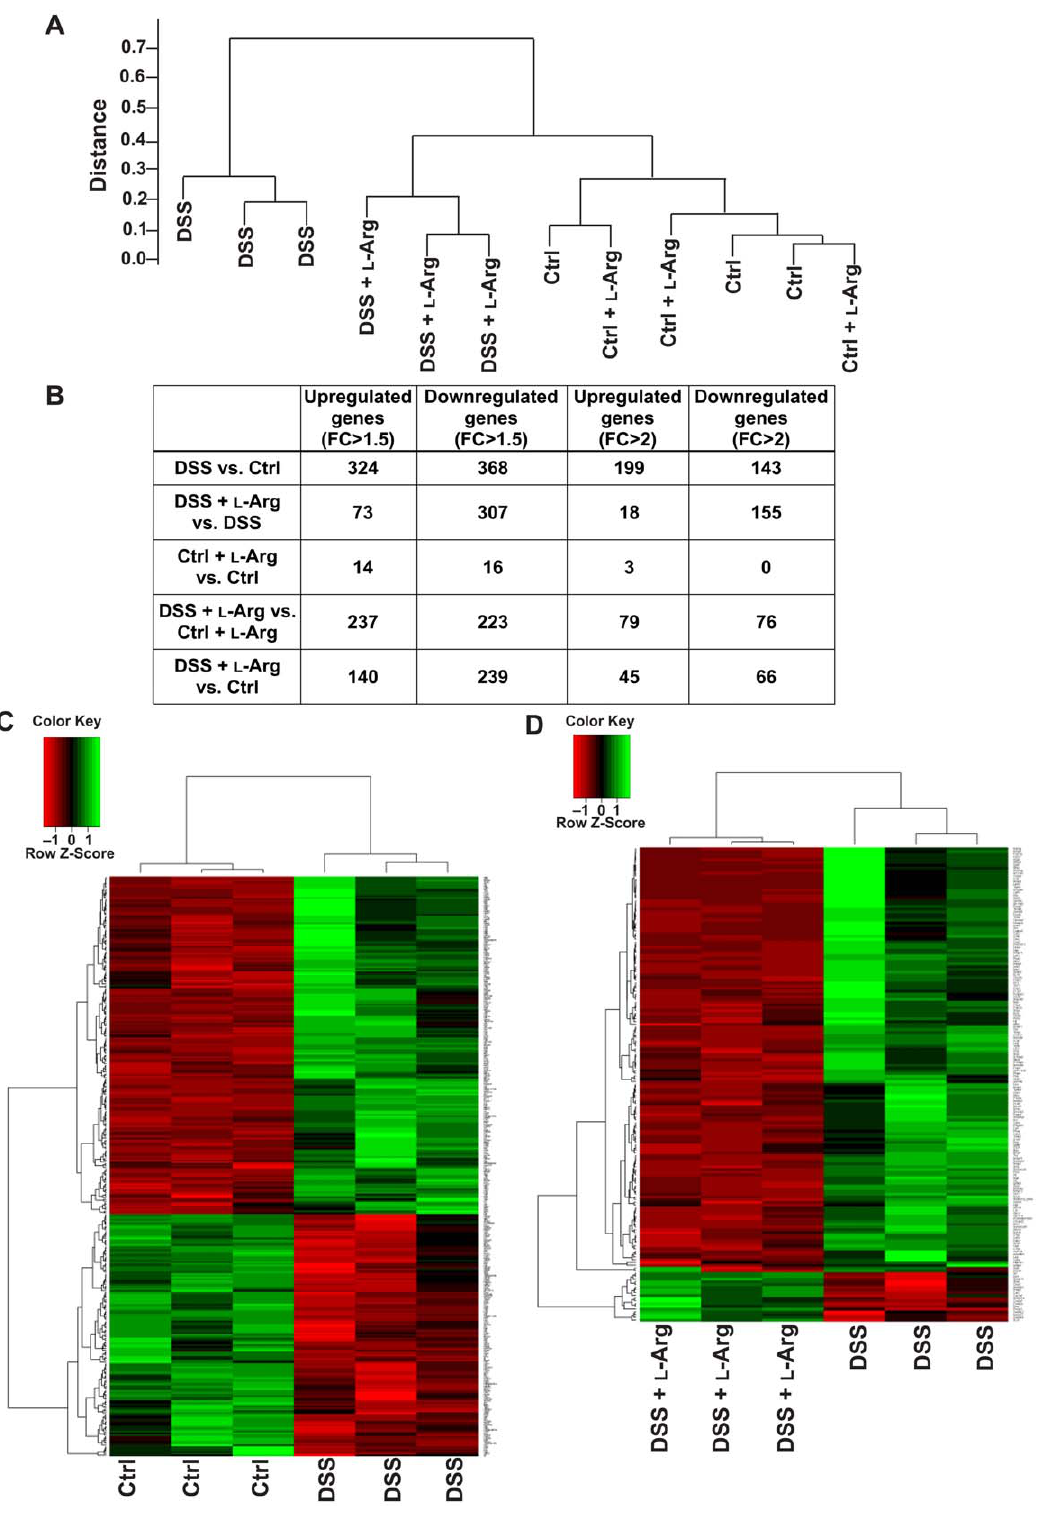
Figure 7. Tissue microarray assessment identifying multiple differentially expressed genes after exposure to DSS. Mice received treatments as in Figures 3–6. There were four groups, namely control (Ctrl), receiving water alone; control + L-Arg, receiving water for 6 days and L-Arg for 4 days; DSS, receiving DSS for 6 days and water for 4 days; and DSS + L-Arg, receiving DSS for 6 days and L-Arg for 4 days. At sacrifice, a piece of colon was obtained and placed in RNAlater H . Three samples from each of the four groups were submitted for microarray assessment. (A) Hierarchical clustering of the samples based on . 16,000 protein-coding genes. The 12 samples were clustered by the expression values of the probes to examine the inter- and intra-groups relationship of the samples. Note that the DSS group was markedly distinct from the Ctrl or the Ctrl + L-Arg groups, and the DSS + L-Arg group segregated closely with the control groups not receiving DSS, rather than with the DSS group. (B) Table of the number of